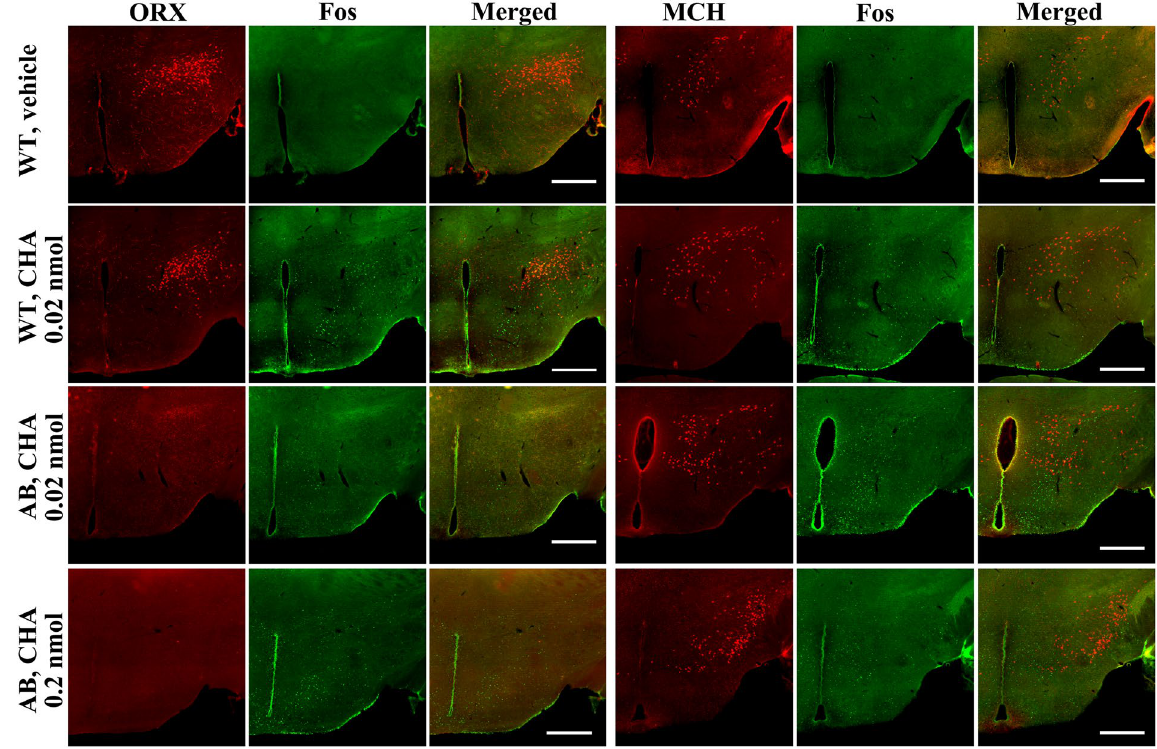
Figure 5. Effect of central administration of CHA on the hypothalamic neurons. Representative photographs show cellular activation marker c-Fos (green), orexin (ORX) or melanin concentrating hormone (MCH) immunoreactivity (red), and merged in the hypothalamus of vehicle-injected WT mice (top row), 0.02 nmol of CHA-injected WT mice (second row), 0.02 nmol of CHA-injected ORX-AB mice (third row), and 0.2 nmol of CHA-injected ORX-AB mice (bottom row). Horizontal bar indicates 500 µ m. Note absence of orexin- immunoreactivity in ORX-AB mice (left end column, bottom 2